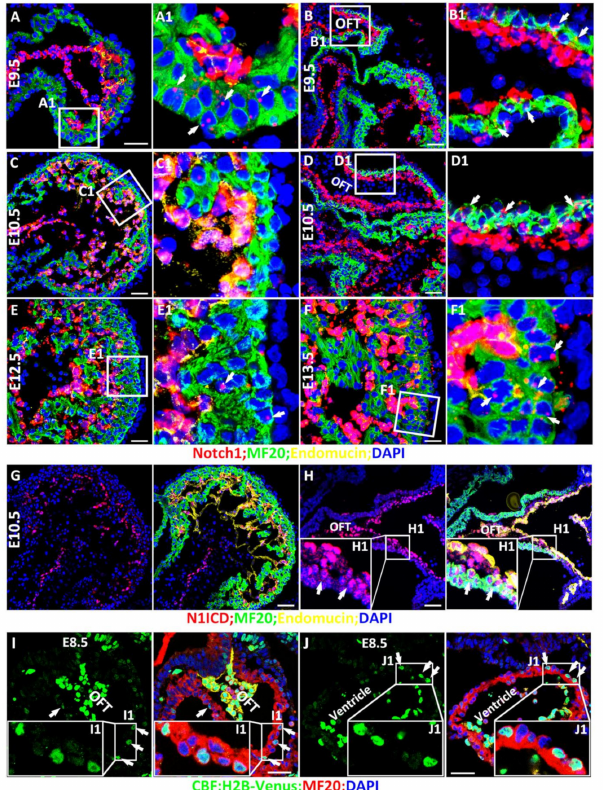
Figure 1. Spatiotemporal expression and activation of Notch1 during cardiac morphogenesis. ( A , B ) Notch1 was mainly expressed in the endocardial cells, and weakly expressed in the